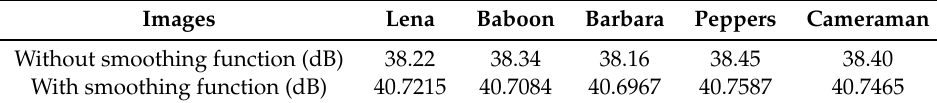
Table 1. The comparison of “without smoothing function” and “with smoothing function”. Images Lena Baboon Barbara Peppers Cameraman Without smoothing function (dB) 38.22 38.34 38.16 38.45 38.40 With smoothing function (dB) 40.7215 40.7084 40.6967 40.7587 40.7465